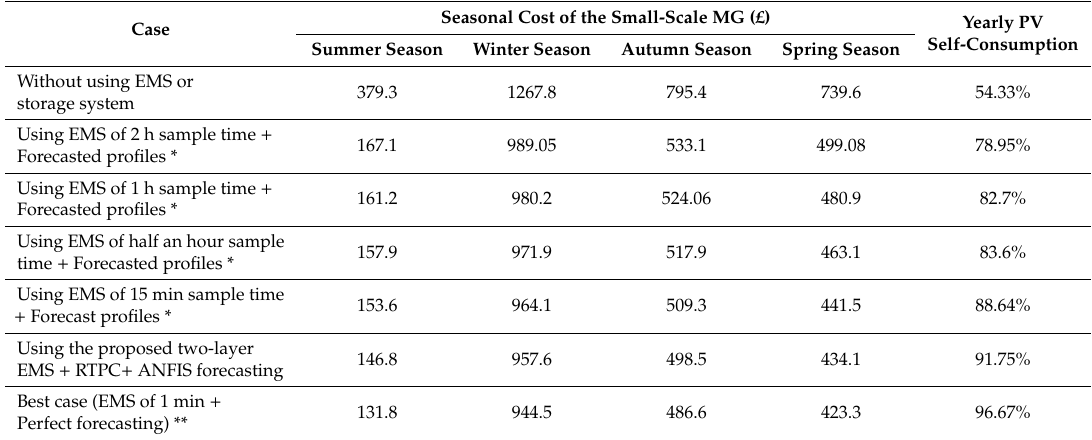
Table 5. Seasonal costs of the energy drawn by the small-scale MG from the main electrical grid as well as the yearly PV self-consumption percent using the proposed EMS and other control